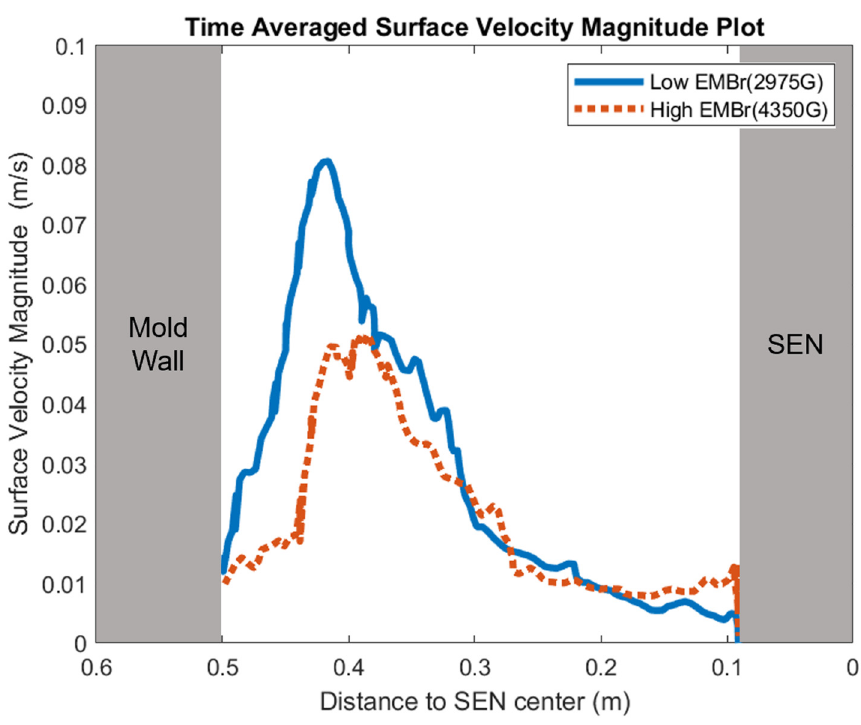
Figure 9. High EMBr strength (Case 1) vs. low EMBr strength (Case 2) standing wave comparison.